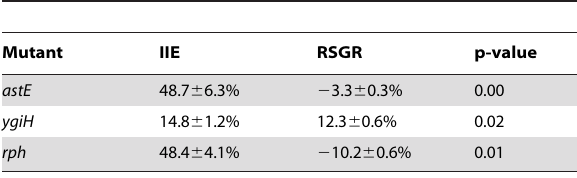
Table 5. Genes that significantly enhance n-butanol tolerance when deleted from the E. coli genome.